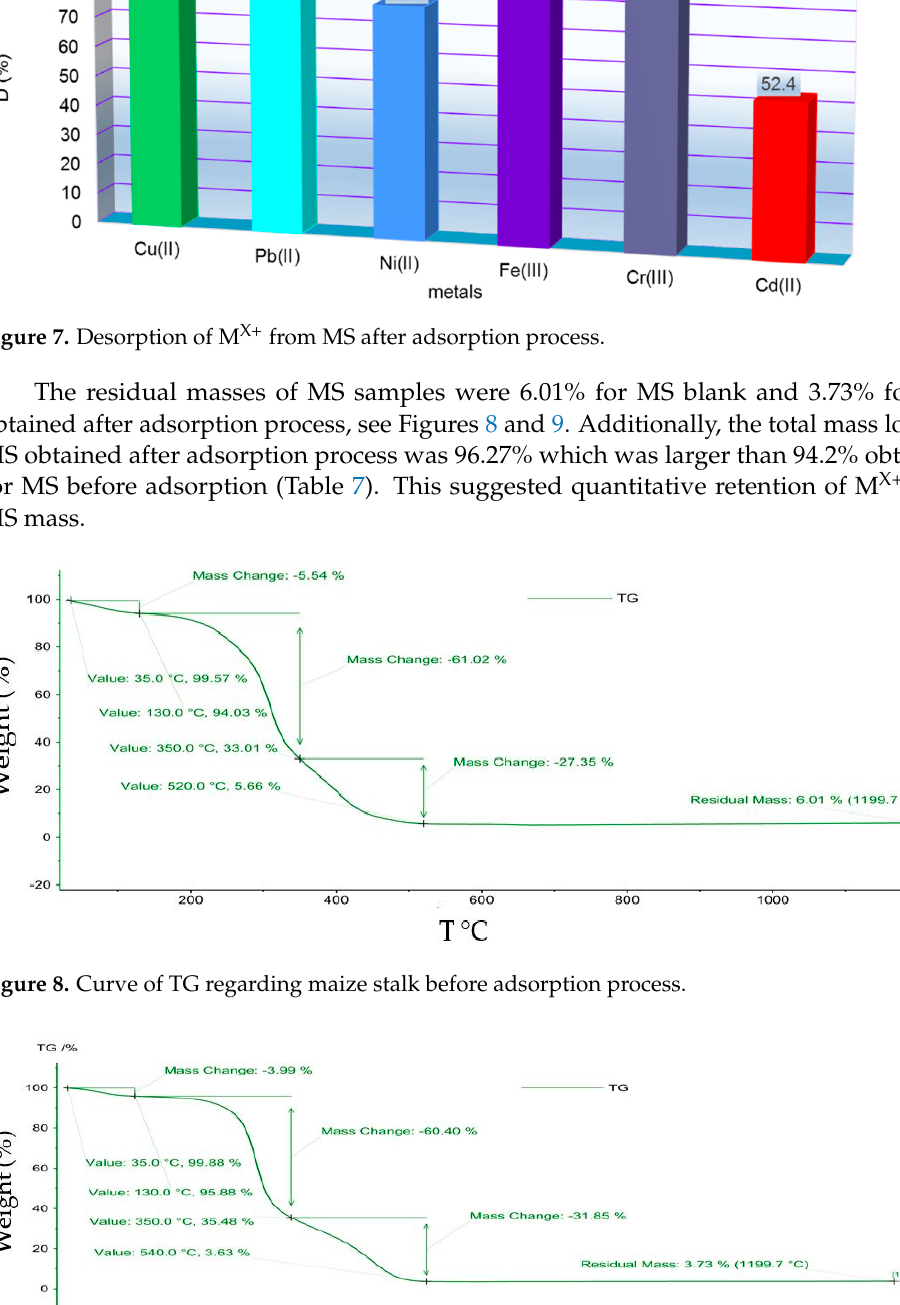
materials as follows. Basu et al. studied the influence of five stirring agents for lead